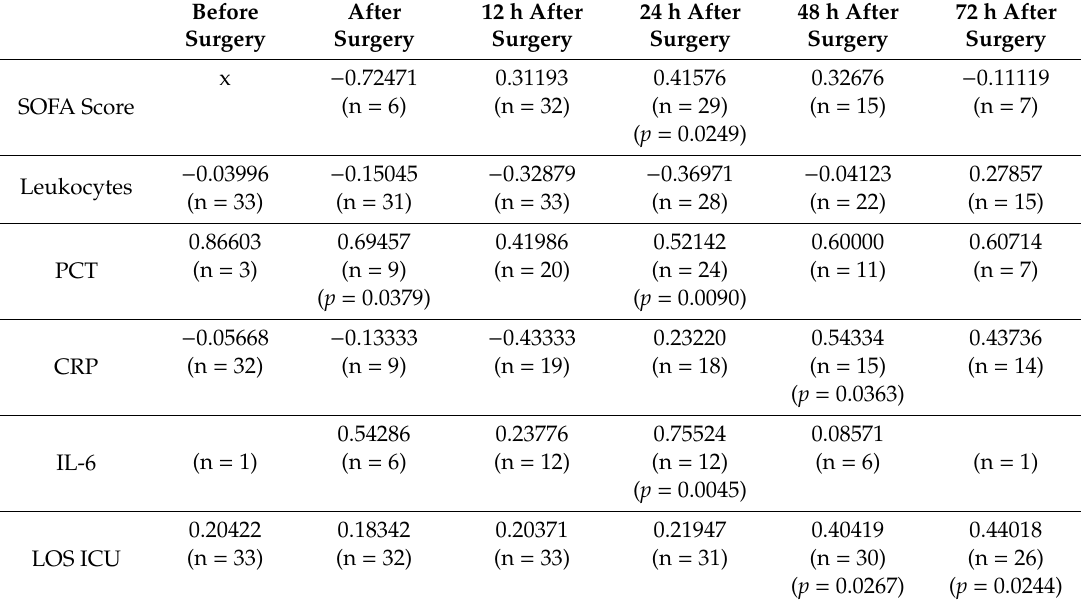
Table 4. Spearman’s correlation coe ffi cient for RNH1 and perioperative variables. The number of included patients is shown below the coe ffi cient. If the coe ffi cient was statistically significantly di ff erent from 0, a p -value is stated below the